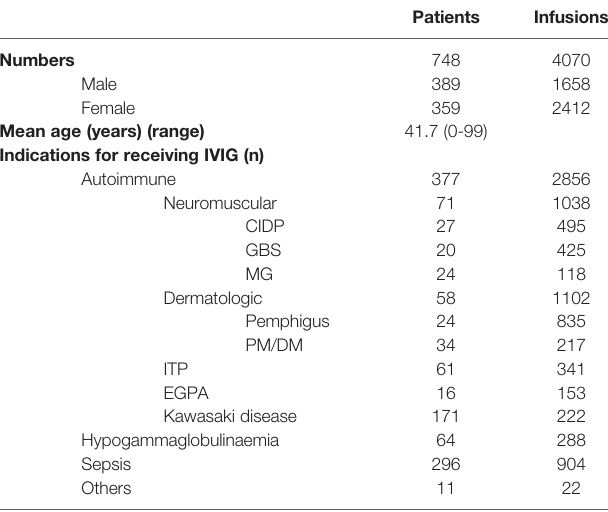
TABLE 1 | Patients